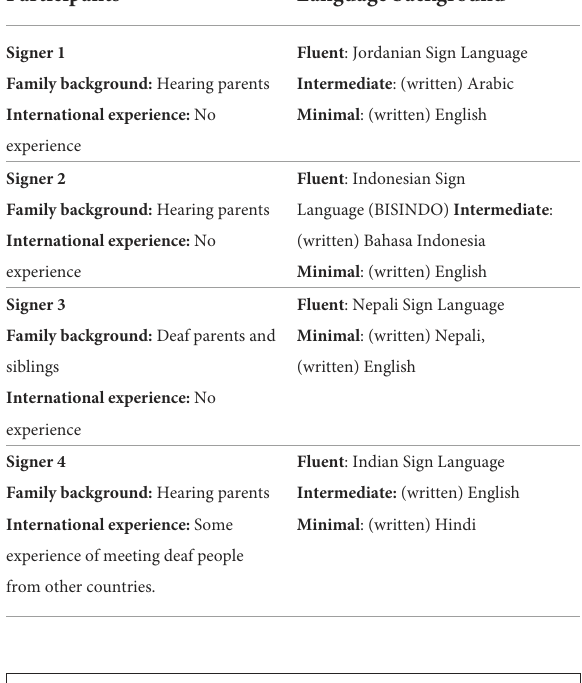
TABLE 1 Language backgrounds of the cross-signing participants in our study.